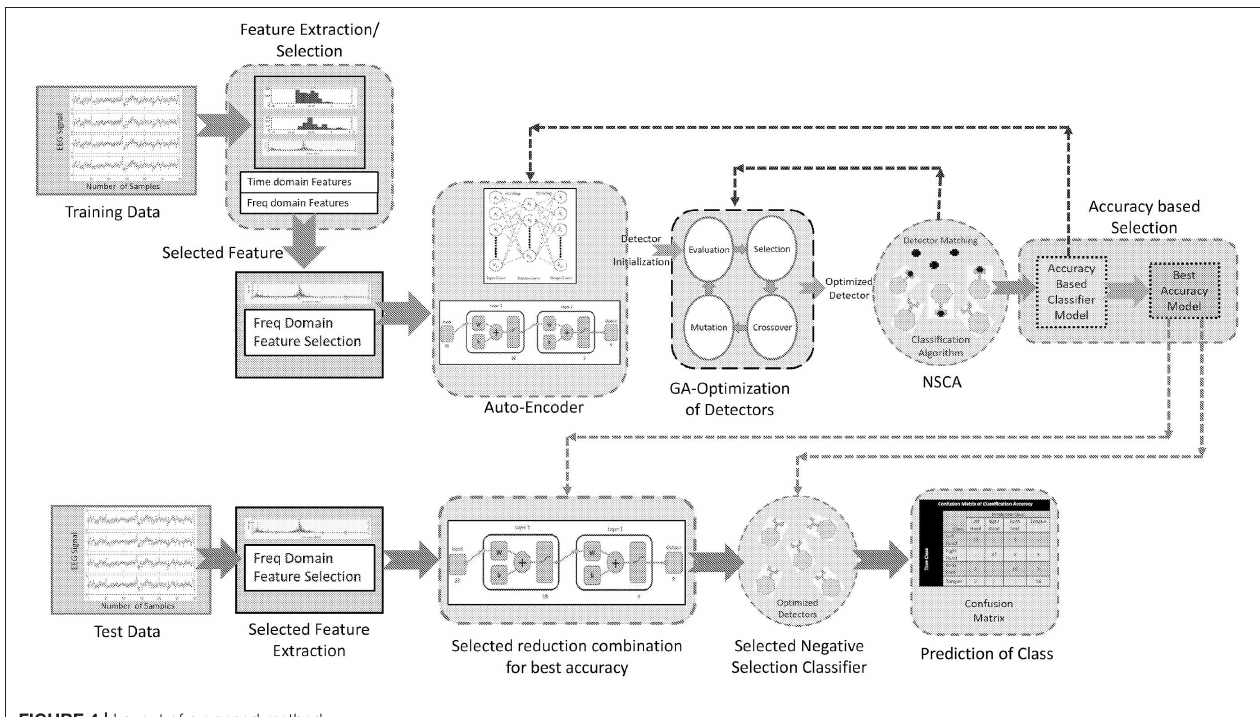
FIGURE 4 | Layout of proposed method.